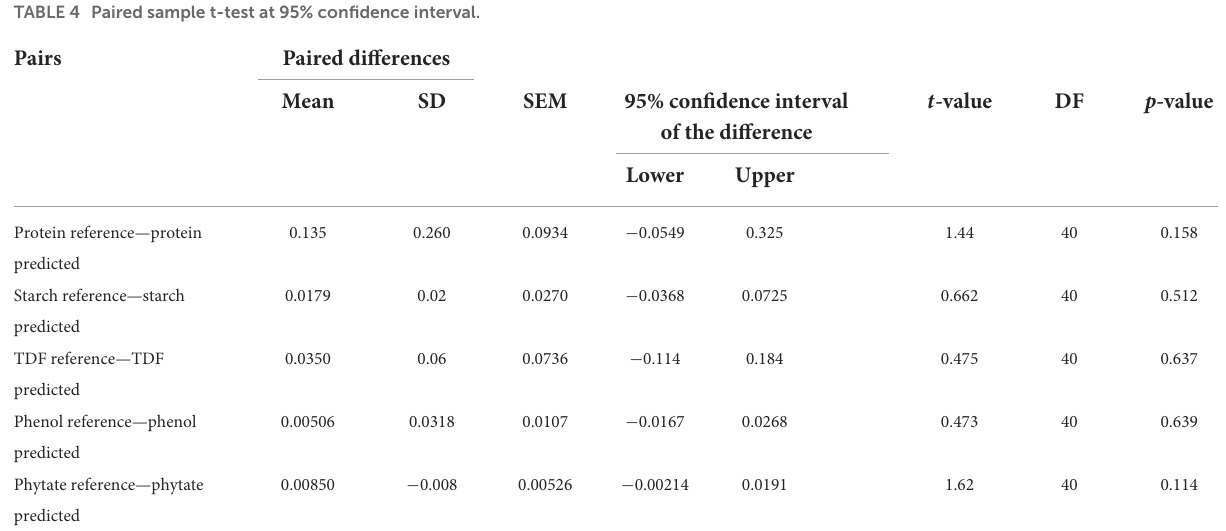
TABLE 4 Paired sample t-test at 95% confidence